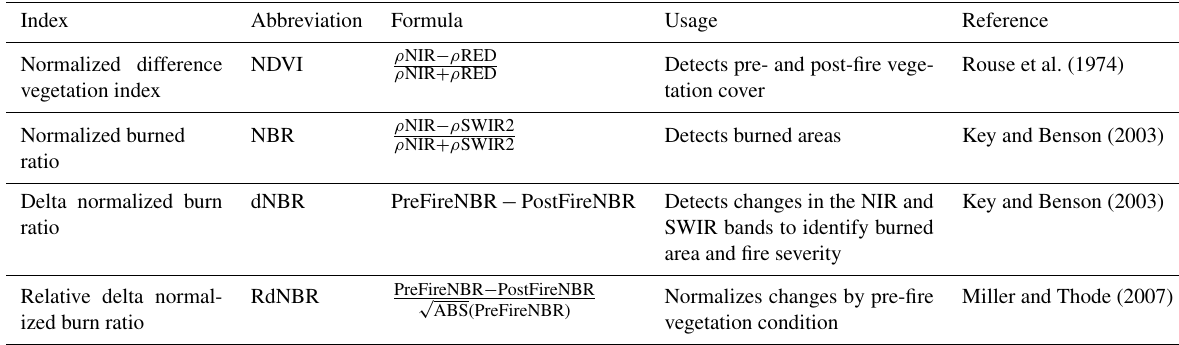
Table 1. Description of the spectral indexes and formulas used in the